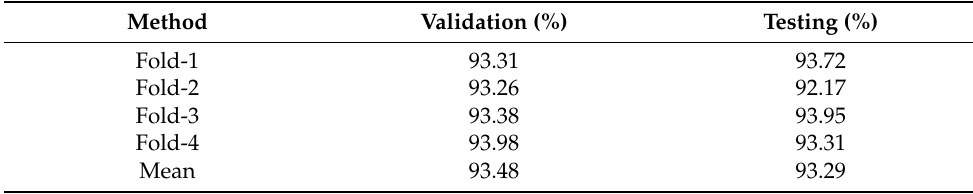
Table 4. Accuracy of four-fold